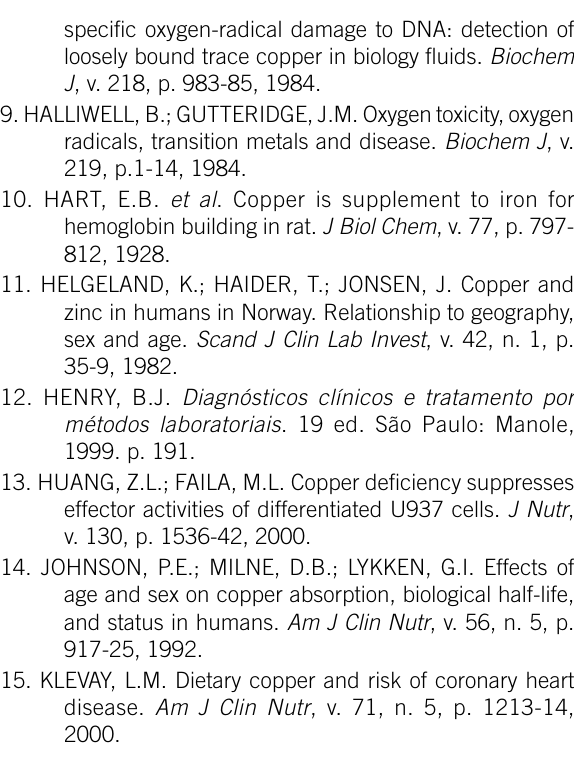
Figura 1 – Correlação entre os métodos espectrofotometria e